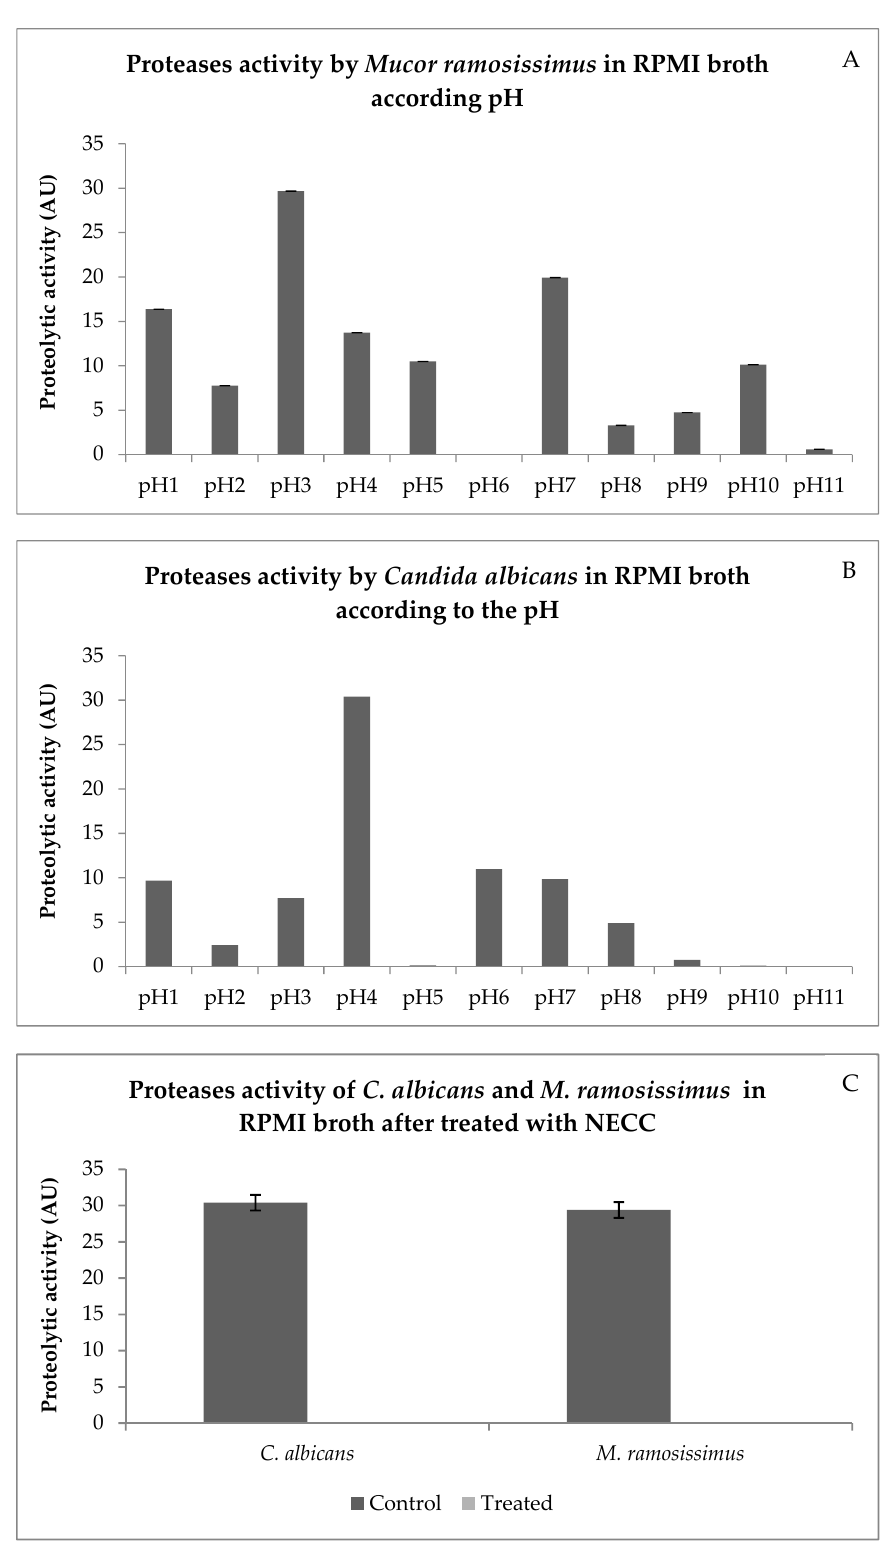
Figure 5. Proteases activity by M. ramosissimus ( A ), C. albicans ( B ) in RPMI broth according to the pH. Proteases activities by C. albicans and M. ramosissimus in RPMI broth after treatment with NECC (in arbitrary unit—AU) ( C ). In addition, NECC demonstrated no hemolytic effect even at the highest concentration tested (2 mg/mL). According to Rodrigues et al. (2013) [10], 7-hydroxycalamenene,